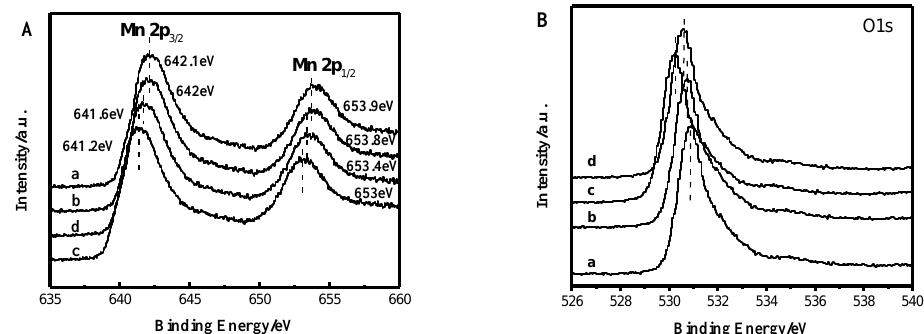
Figure 4. XPS spectra of ( A ) Mn 2p and ( B ) O 1s . (a) Mn 3 O 4 / CNTs-1 CNTs, (b) Mn 3 O 4 / CNTs-2, (c) Mn 3 O 4 / CNTs-3, (d) Mn 3 O 4 / CNTs-4.